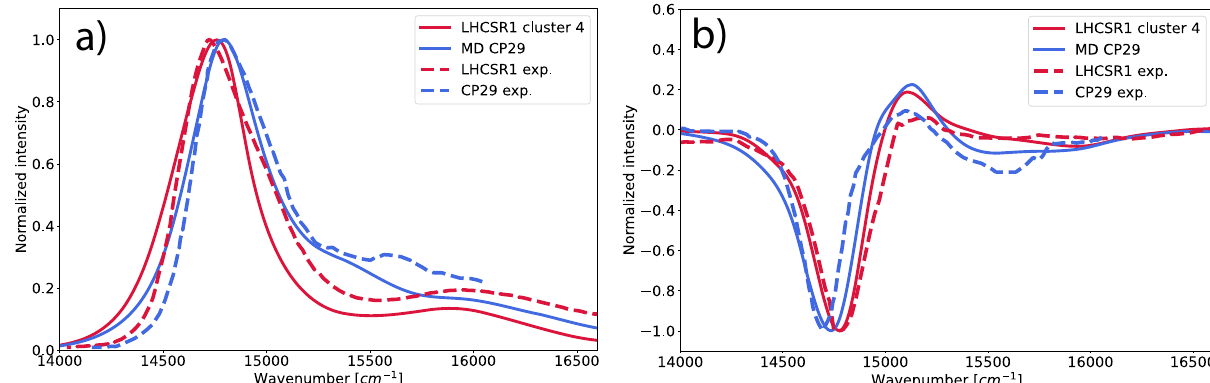
Fig. 6 Comparison between LHCSR1 and CP29 optical spectra. Spectra computed for the LHCSR1 cluster 4 and CP29 (solid lines), compared with the experiment (dashed lines). a absorption spectra, b CD spectra. Note that calculated Chl site energies were all shifted by the same amount ( − 1381 cm − 1 ) to account for the error of the quantum chemical method; this shift was determined independently on LHCII (see “ Methods ” ). The optical spectra for the cluster 4 of the LHCSR1 were obtained by averaging over spectra of 102 con fi gurations (replicas MD7 and MD8) and for CP29 by averaging over 79 con fi gurations. The experimental spectrum for LHCSR1 was taken from ref. 20 and the CP29 one was taken from ref. 52